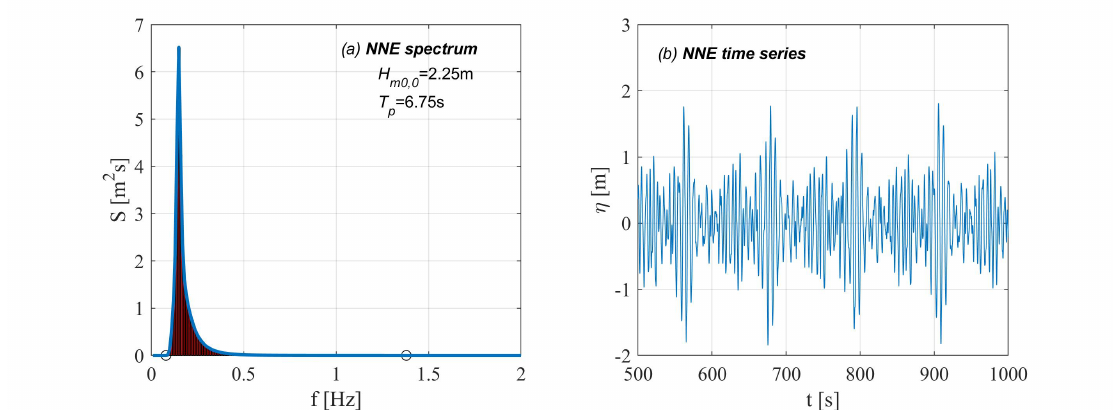
Figure 3. Example of the offshore boundary condition generation: ( a ) spectrum of the NNE wave; ( b ) surface-level time